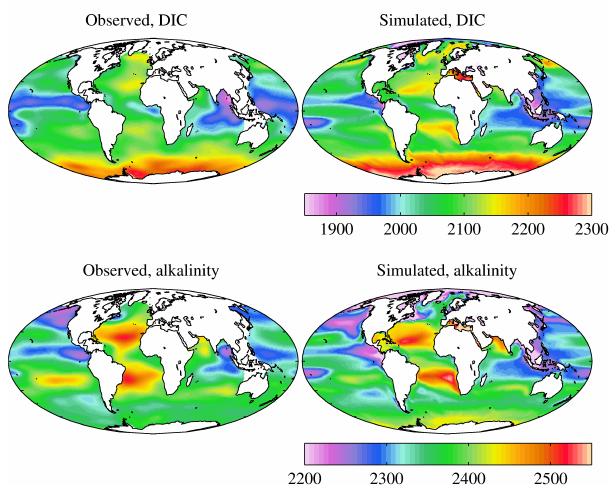
Fig. 18. Intercomparison of observational (left) and model (right) fields of zonally averaged alkalinity for the Atlantic (top) and Pa- cific (bottom) basins. Note that the GLODAP climatology has no values within the Arctic. Concentrations in meqm − 3 .